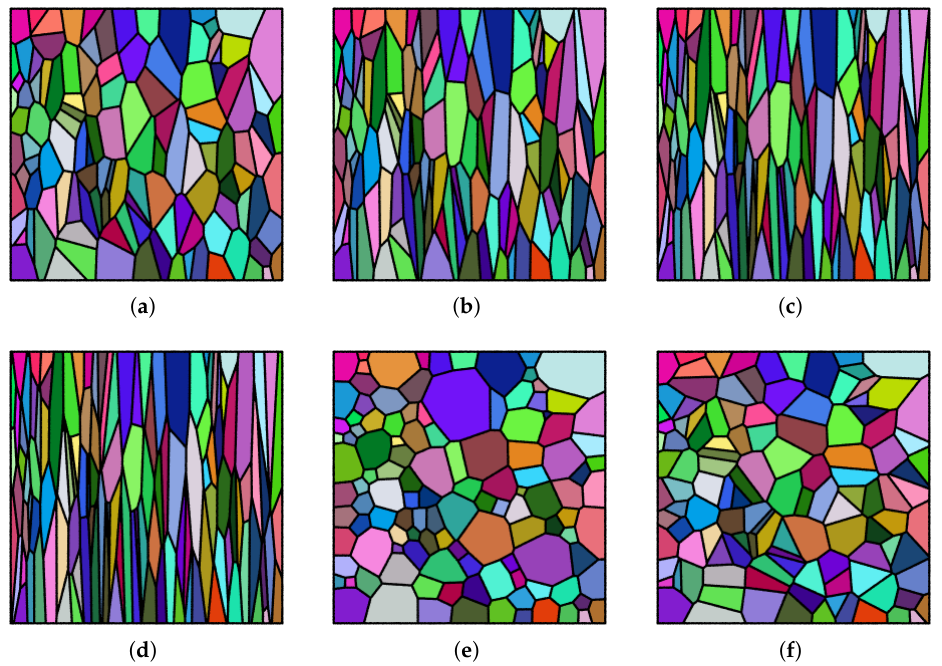
Figure 1. Data consisting of six different types of microstructures. ( a ) Columnar grain structure with aspect ratio 1:2, ( b ) Columnar grain structure with aspect ratio 1:4, ( c ) Columnar grain structure with aspect ratio 1:6, ( d ) Columnar grain structure with aspect ratio 1:8, ( e ) Grain growth (gg) grain structure ( f ) Voronoi grain structure. Note that the grain growth structure was produced based on a grain growth algorithm applied in addition to Voronoi tessellation. This algorithm is part of the NEPER